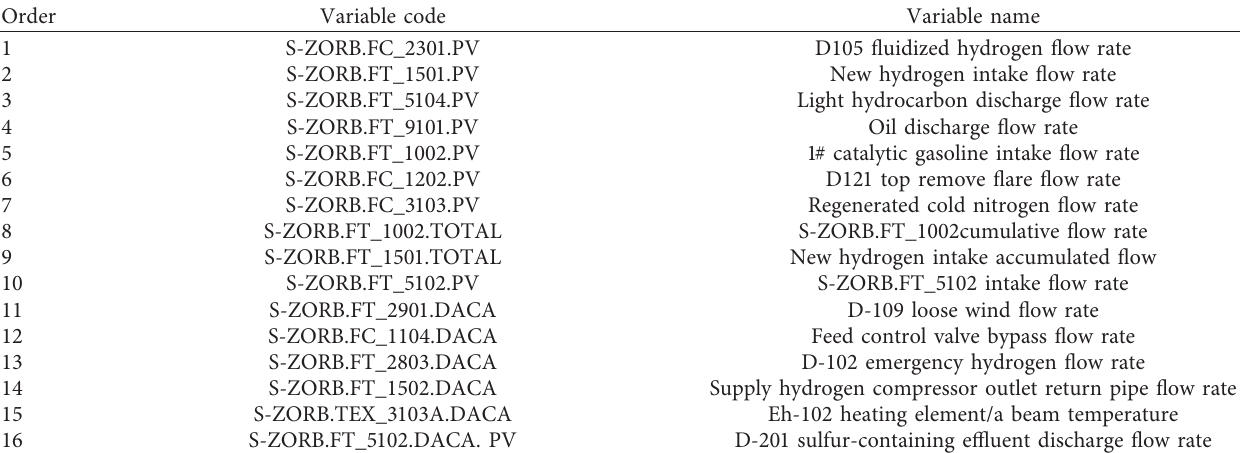
Table 1: The eliminated